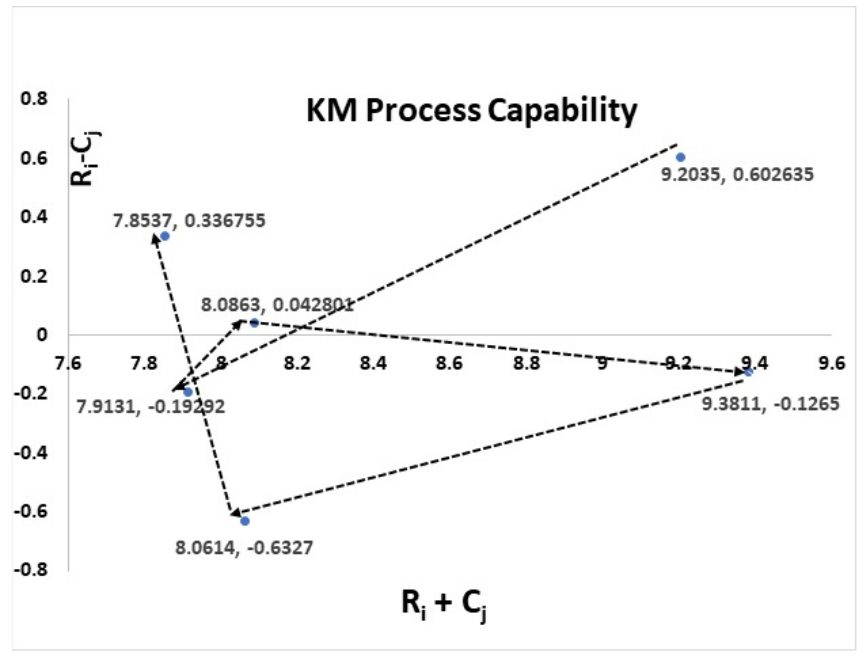
Figure 7. The IRM for the KM process capability (T Criteria ).